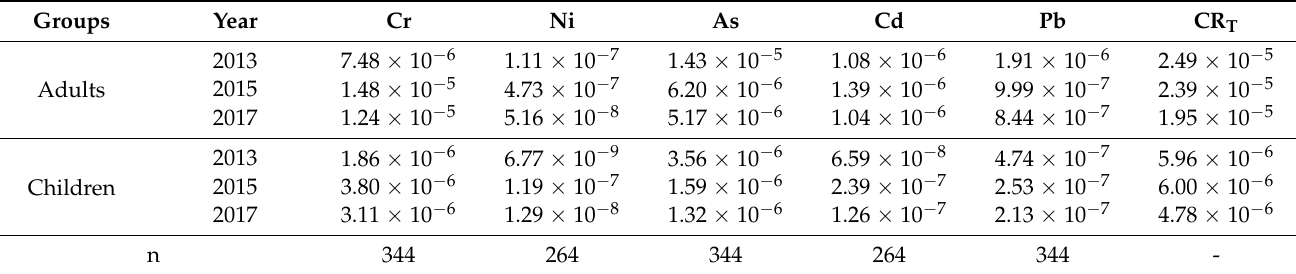
Figure 7. The annual HQ associated with the non-carcinogenic heavy metal components of PM 2.5 (n V = 344, n Cr = 344, n Mn = 344, n Ni = 264, n As = 344, n Cd = 264). Table 3. The annual carcinogenic risk of the heavy metals in PM 2.5